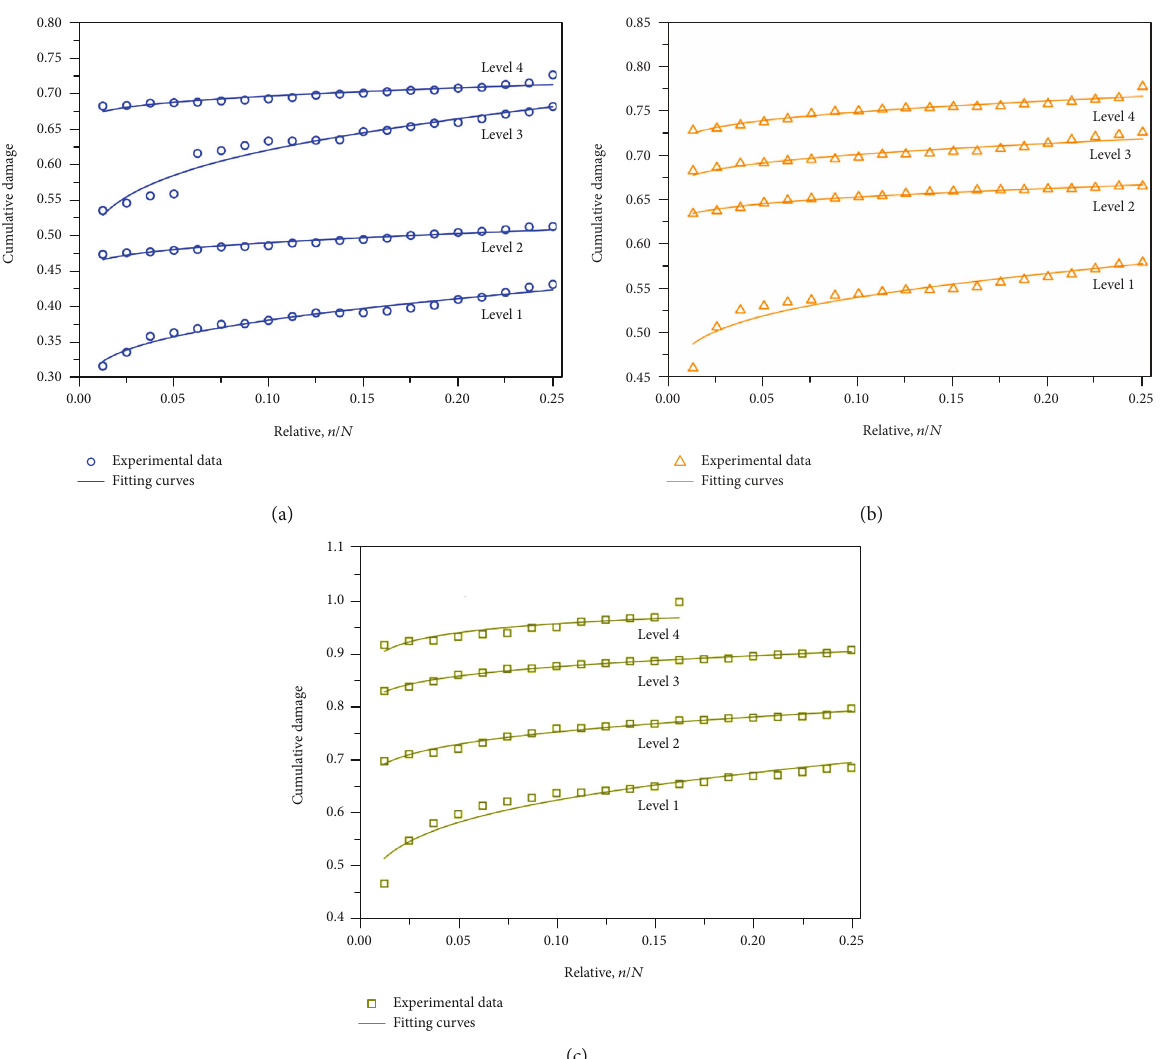
Figure 14: Comparison between the experimental values and fi tting results versus relative cycle at di ff erent loading frequencies: (a) 0.1Hz; (b) 0.2Hz; (c) 0.5